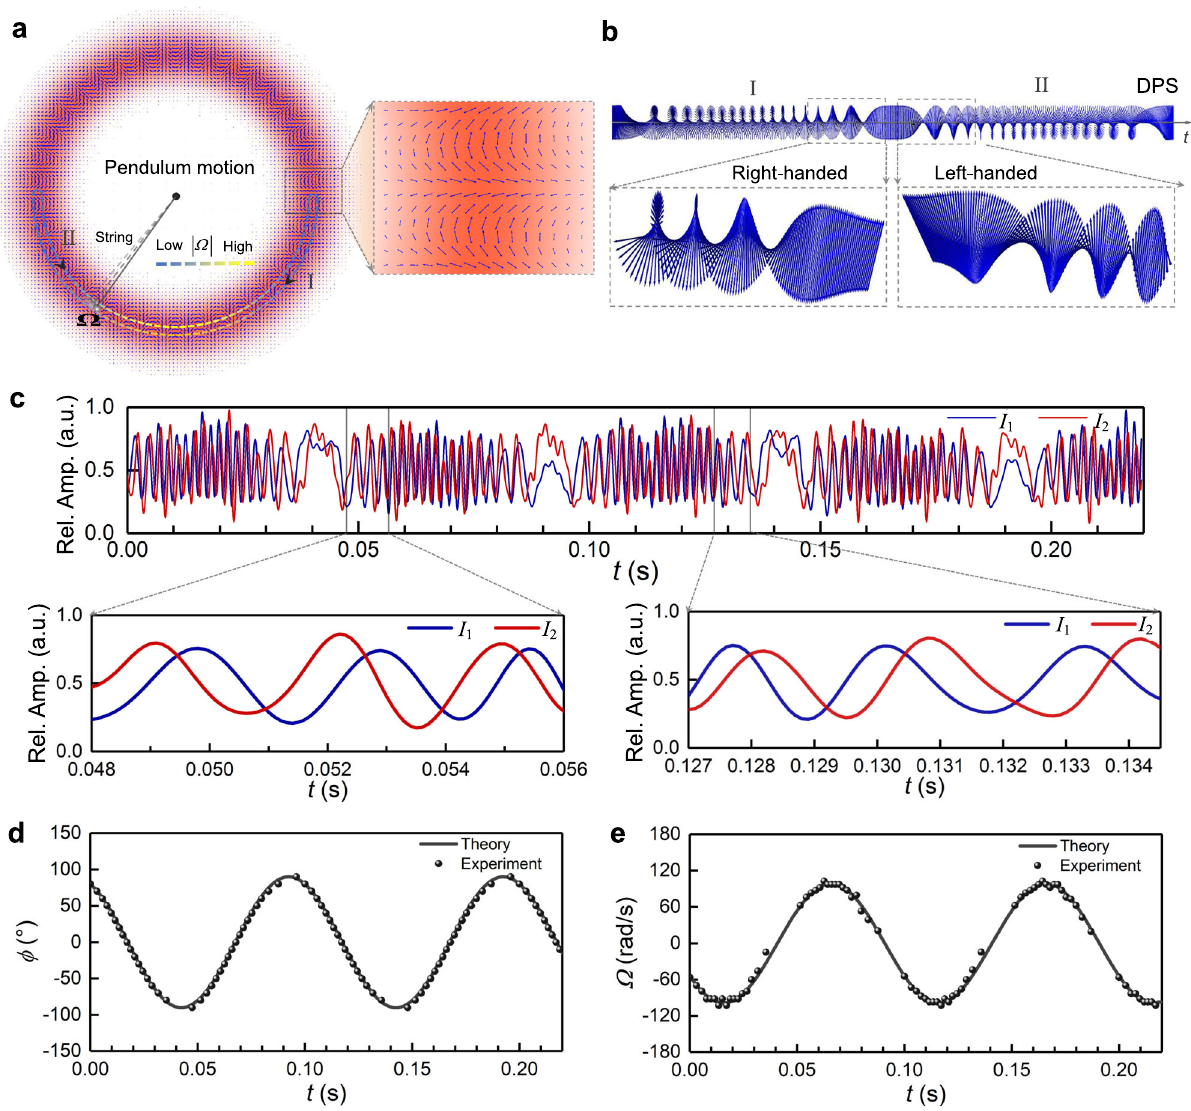
Fig. 5 Real-time tracking of instantaneous position and velocity of a complicated moving particle based on vectorial Doppler effect with spatially variant polarized light fi elds, provided that the particle path and starting position of the moving particle are given and the particle is continuously tracked. a A moving particle with pendulum motion is illuminated by the higher-order cylindrical HE 19,1 -like VPF. The inset shows zoom-in details of spatial polarization distribution of the HE 19,1 -like VPF. b DPS (Simulated) re fl ected from the HE 19,1 -like VPF is available to retrieve the instantaneous position and velocity vector information of the moving particle. c Measured Doppler intensity signals after fi ltering the DPS (Fig. 5b) by two polarizers. The insets are zoom-in details of the measured Doppler intensity signals in two different time windows. a.u. arbitrary unit. d Retrieved instantaneous angular positions. e Retrieved instantaneous angular velocities. The dots represent experiments and the solid lines denote